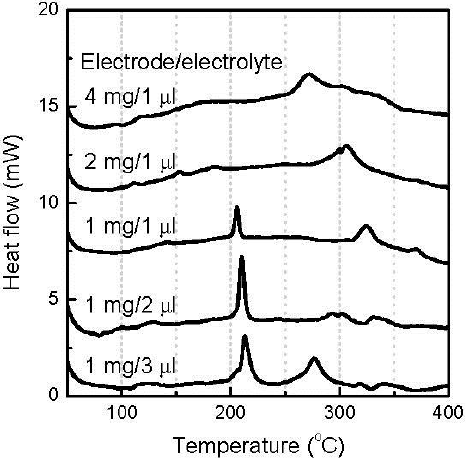
Figure 4. DSC curves of the discharged FeOF cathode down to 2.0 V with associated electrolytes in various cathode/electrolyte ratios.